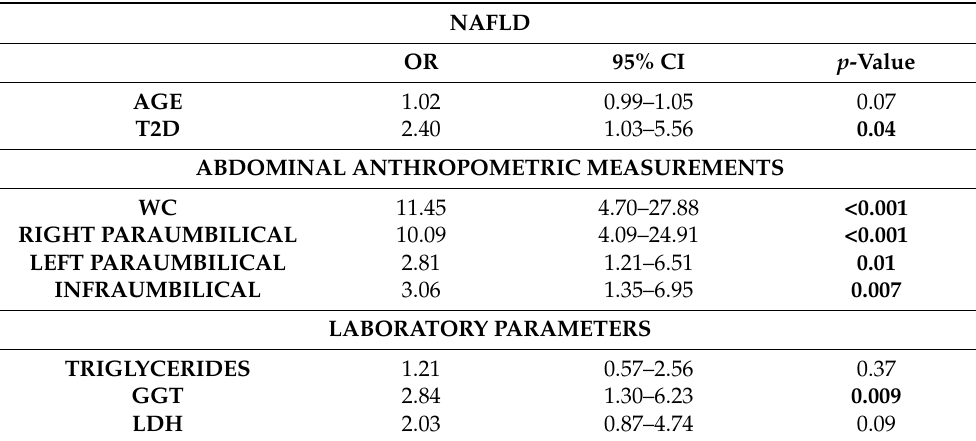
Table 3. Multivariate analyses of the age, risk factors, abdominal anthropometric measurements, laboratory parameters, and the NAFLD risk.